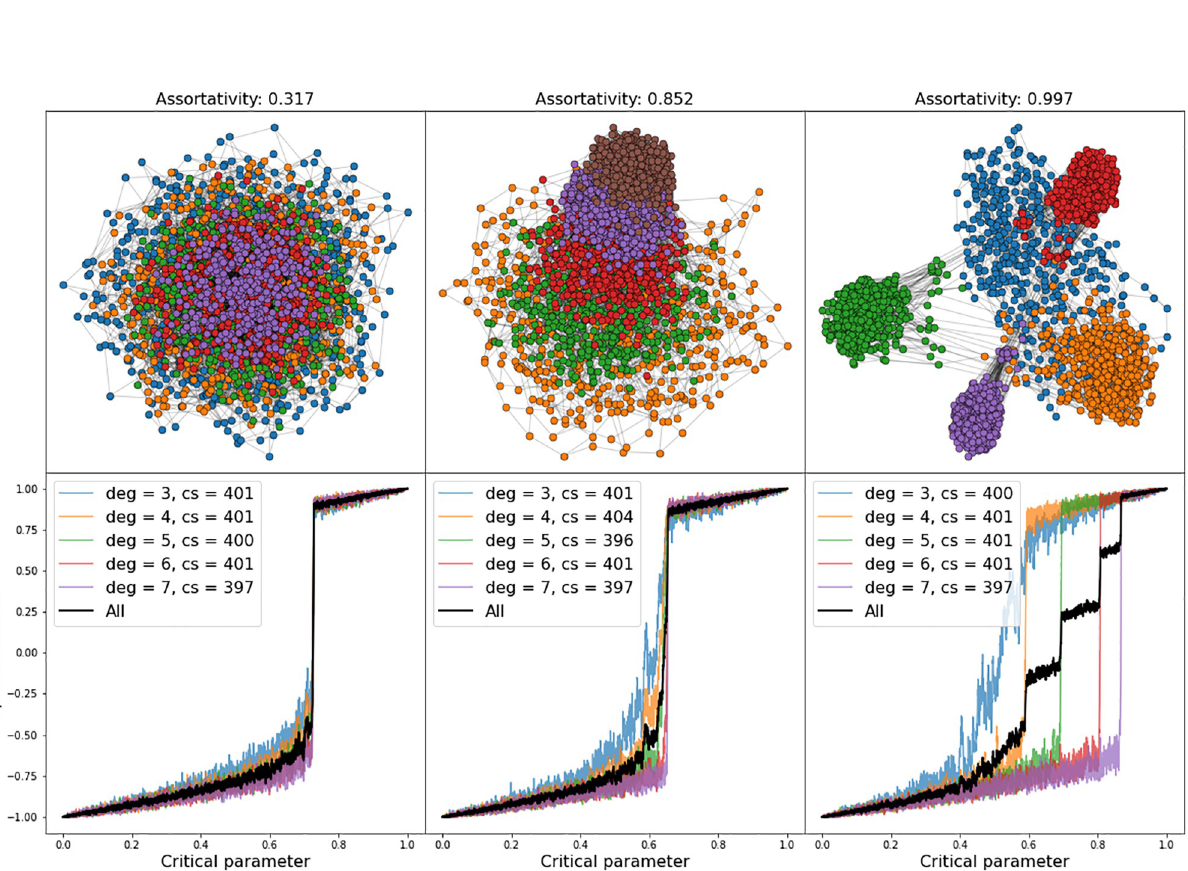
Fig 2. Networks with different assortativity levels on varying link-degrees and corresponding CTs in a model implementation with α = 0.7, showing that the onset of the CT takes its initial momentum in the low-degree clusters (orange and green) and that while there is quite some variation in spin-orientation in the low-degree clusters, the higher degree nodes tend to shift their spin orientation nearly in unity.